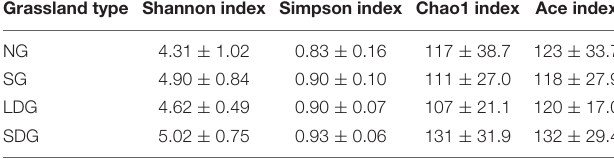
TABLE 4 | Alpha diversity of asymbiotic nitrogen-fixing microbial communities in different grassland